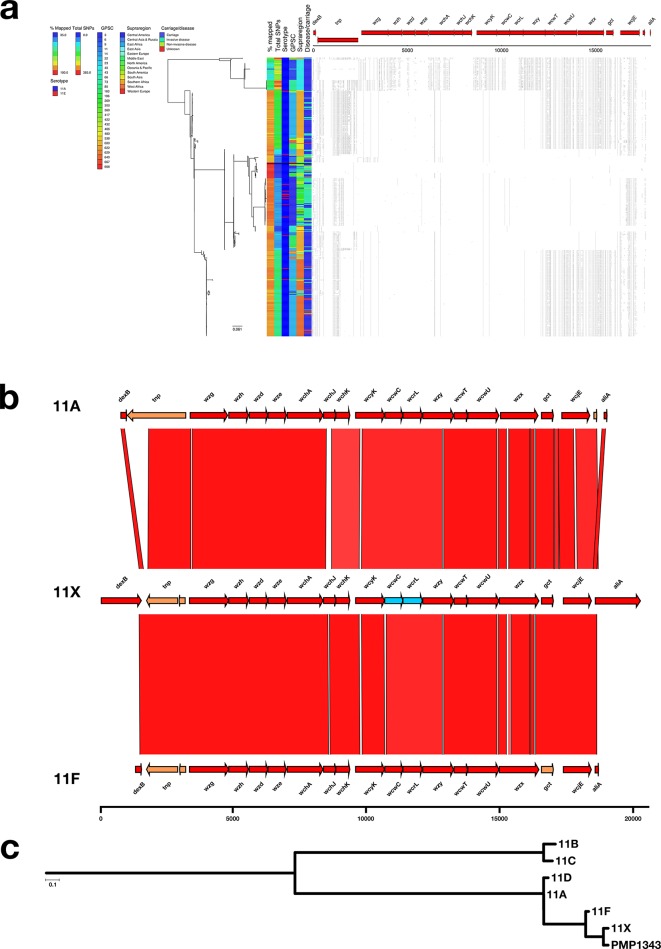
(a) Phylogeny and SNP map of serotype 11A. (b) Comparison of the putative serotype 11X sequence and the serotype 11A and 11F reference sequences. (c) Phylogeny containing the serogroup 11 references, serotype 11X and PMP1343.